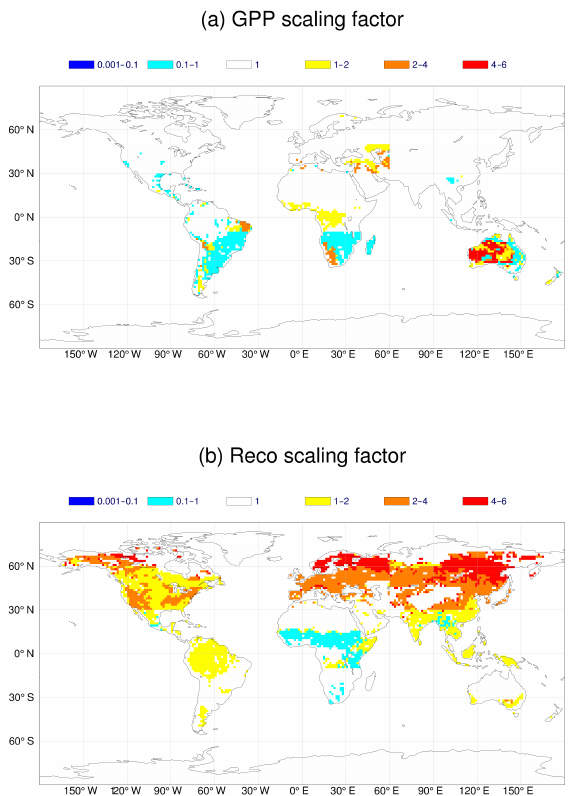
Figure 6. Map of scaling factors for (a) GPP and (b) R eco on 15 March